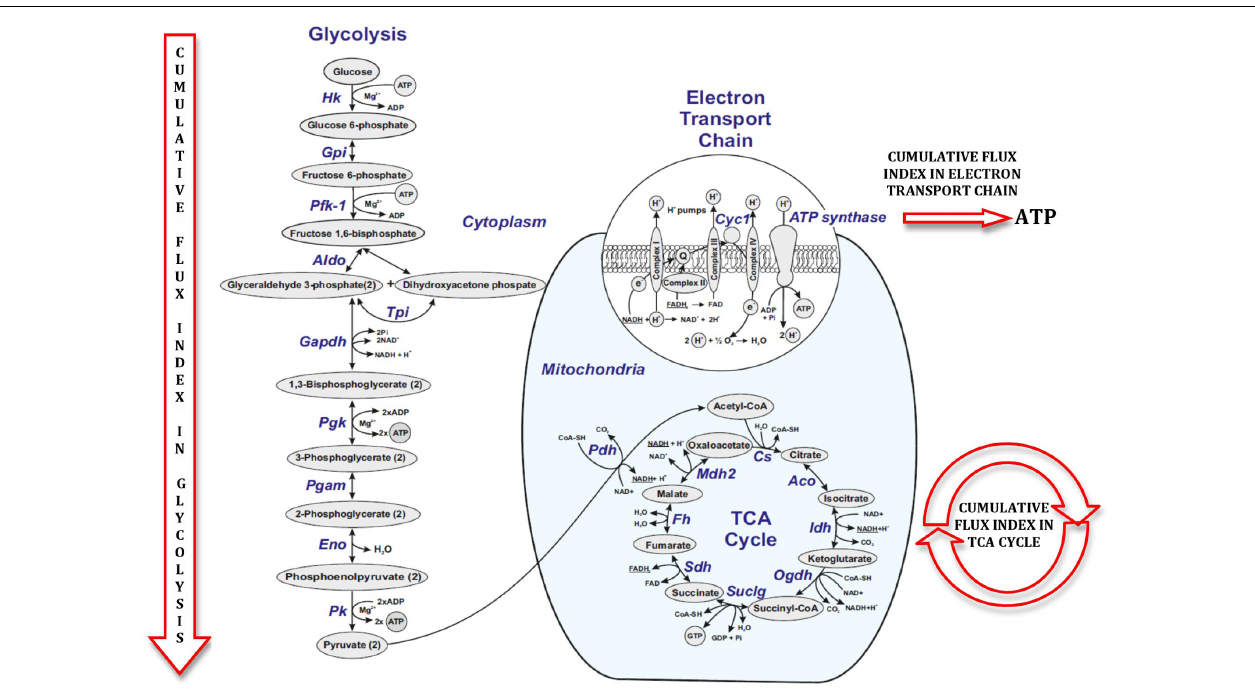
FIGURE 5 | Figure illustrating cumulative flux index in glycolysis, TCA cycle and electron transport chain in glucose metabolic pathway.